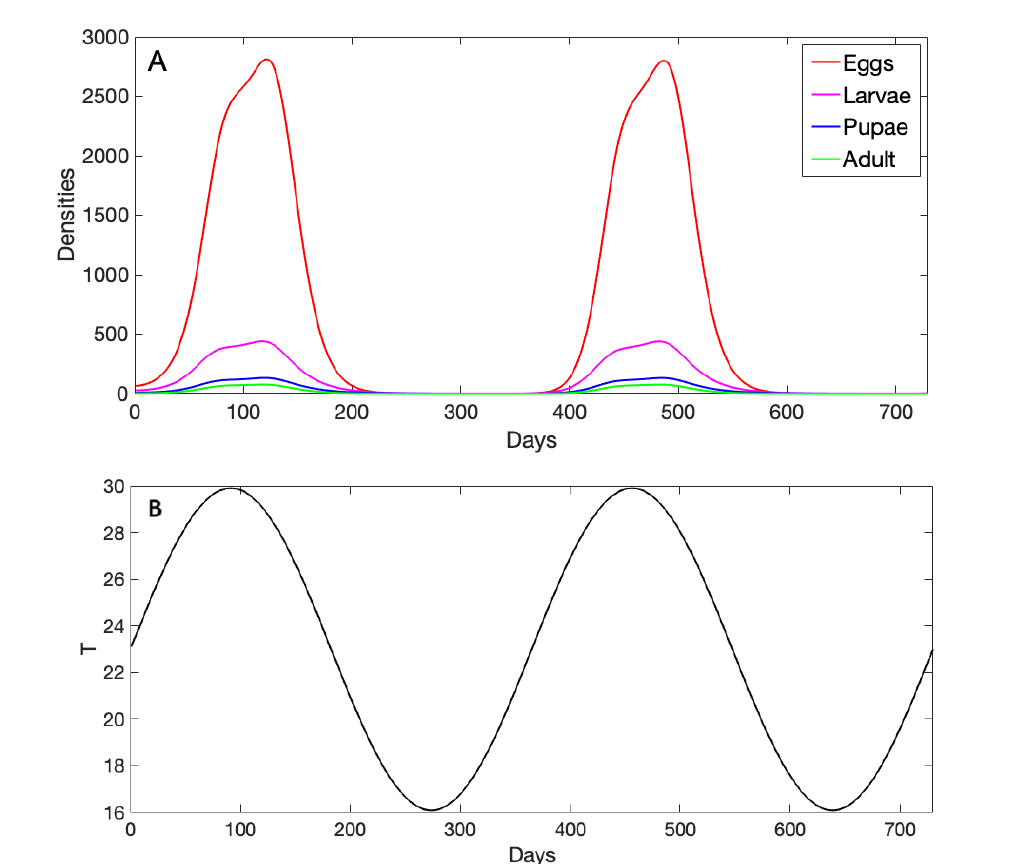
Figure 3. ( A ) Daily mosquito life stage densities evaluated for 730 days (two years). The lines show the numerical solution of our dynamical model for eggs, larvae, pupae, and female adult life stages, and the parameter values used here are given in Table 1. ( B ) The corresponding daily temperature given by a sine function ( T 0 ( 1 + B sin ( 2 π t /365) with T 0 = 23 and B = 0.3) evaluated for 730 days (two years) used to evaluate our thermal traits incorporated into the dynamical